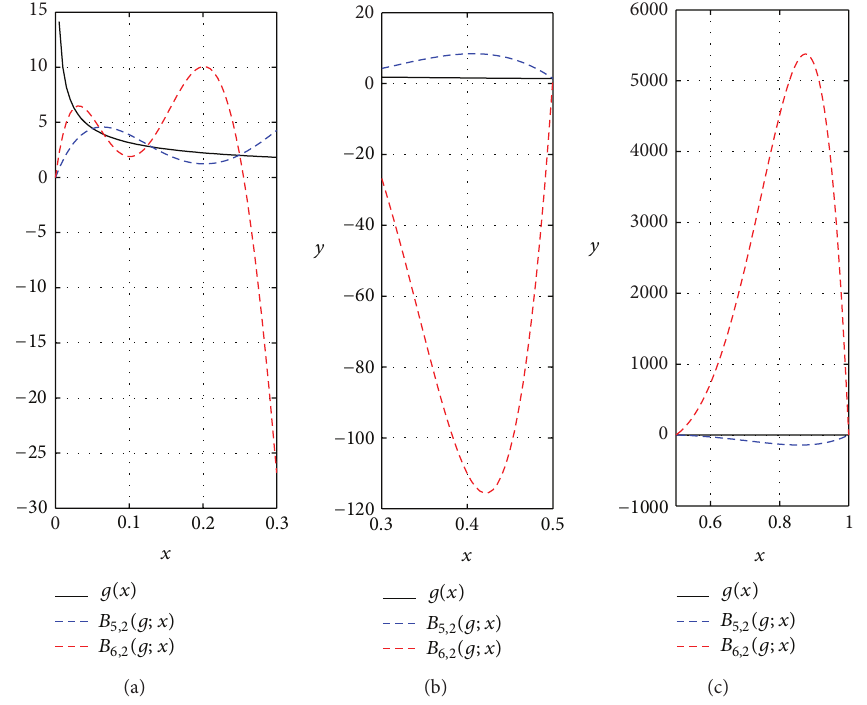
Figure 2: Graphs of 𝑦 = 𝑔(𝑥) and 𝑦 = 𝐵 𝑛,2 (𝑔;𝑥) , 𝑛 = 5, 6 .